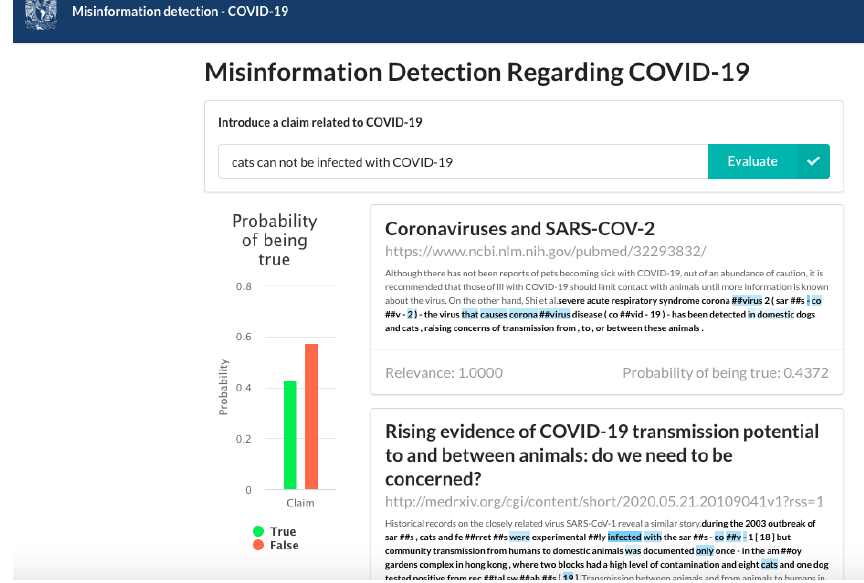
Figure 7. Web interface to verify claims related to